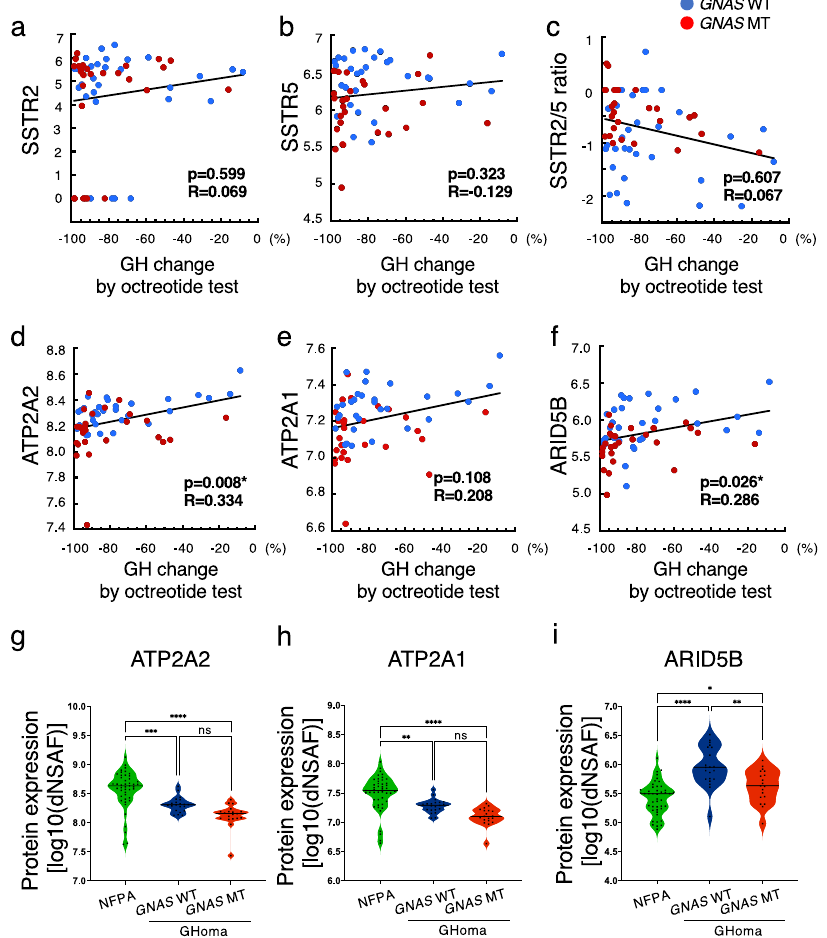
Fig. 5 Correlation between protein expression levels and GH change rates in the octreotide loading test. Correlations between ( a ) somatostatin receptor 2 (SSTR2) protein expression, ( b ) SSTR5 protein expression, ( c ) the SSTR2/5 ratio, ( d ) sarcoplasmic/endoplasmic reticulum calcium ATPase 2 (ATP2A2) protein expression, ( e ) ATP2A1 protein expression, and ( f ) AT-rich interaction domain 5B (ARID5B) protein expression and growth hormone (GH) change ratio by octreotide loading test (%). Data were analyzed by Pearson ’ s correlation analysis. g ATP2A2, ( h ) ATP2A1, and ( i ) ARID5B protein expression levels in NFPA, GNAS -WT GHoma, and GNAS -mutant (MT) GHoma. All protein expression values were log (base 10) transformed. NFPA: nonfunctional pituitary adenoma/non-functioning pituitary neuroendocrine tumor (PitNETs), GHoma: GH-producing pituitary adenoma/somatotroph Pituitary neuroendocrine tumor (PitNETs). * p < 0.05, ** p < 0.01, ***p < 0.001, ****p < 0.0001 by 1-way ANOVA. a – f n = 34 in GHoma with GNAS WT, n = 26 in GHoma with GNAS MT. g – i n = 45 in NFPA, n = 21 in GHoma with GNAS WT, n = 19 in GHoma with GNAS